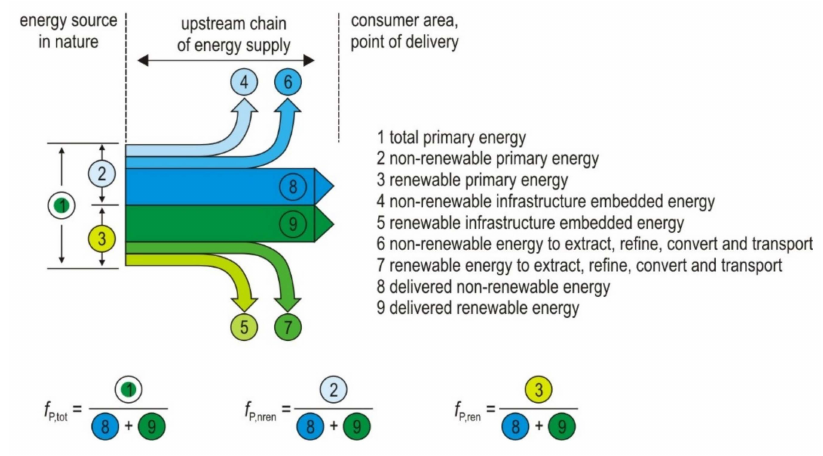
Figure 1. Primary energy factors and energy flows (own elaboration based on [1]).